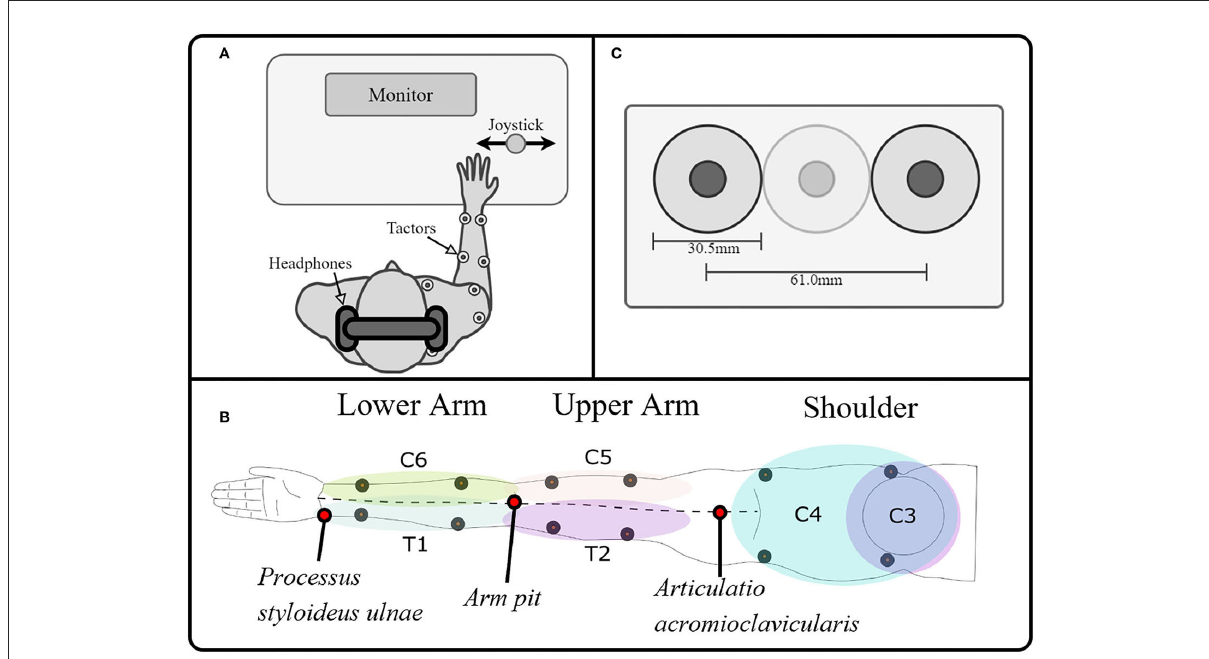
FIGURE1 Experimental setup. (A) The experimental setup consisted of a PC for data recording, visual instructions, and tactile stimulation; a stimulator to control the tactors; and a joystick as the user interface. The subject was wearing noise-canceling headphones on which white noise was played whenever the tactors were on, to drown the noise generated by the vibration. (B) . A total of 12 tactors were placed on the arm and shoulder/ neck, stimulating the dermatomes innervated by the cervical spinal nerves C6, C5 proximally and distally, the thoracic spinal nerves T1 and T2 proximally and distally, and the cervical spinal nerves C3 and C4 ventrally and dorsally, making it possible to map the tactile sensation to vibration over the whole arm. We divided the limb into three segments and evaluated each of them separately. These segments were defined as the lower arm (mainly innervated by T1 and C6), the upper arm (mainly innervated by T2 and C5), and the shoulder (mainly innervated by C3 and C4). (C) Additionally, we ensured that two tactors were always separated by at least a tactor-diameter, such that the minimum distance between the vibration centers was at least